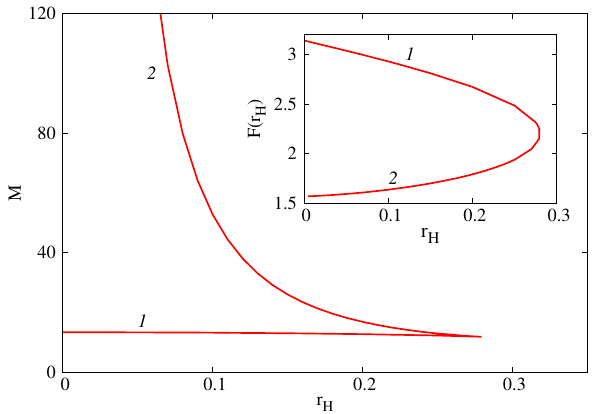
Figure 5 . The mass M and the control parameter F ( r H ) are shown as functions of the horizon radius r H , for Skyrme probe solutions on a Schwarzschild BH